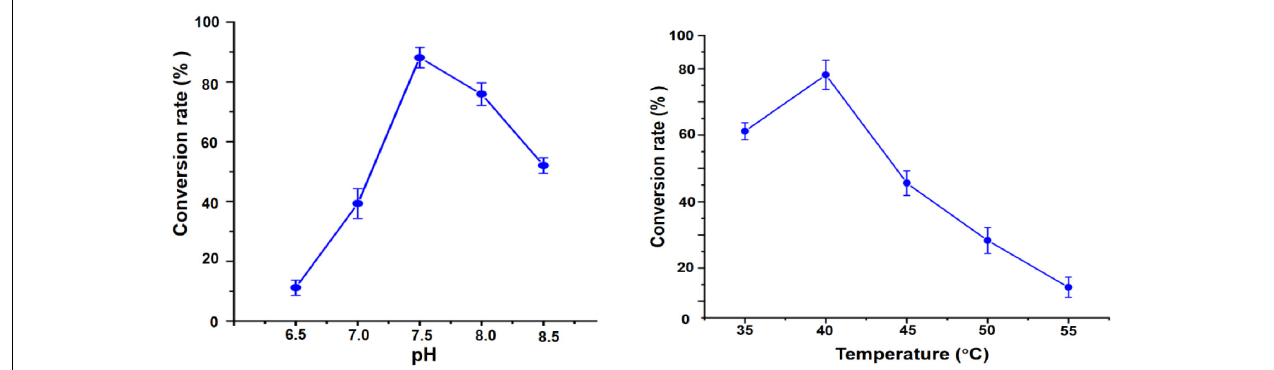
FIGURE 5 | pH and temperature effects on the UGT109A3-SUS biocatalytic cascade reaction. Data represent the mean value ± standard deviation of three measurements.